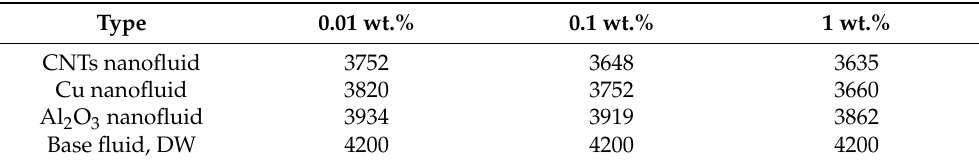
Table 3. Effect of varying nanoparticle concentration on the specific heat (J/kg · ◦ C) of nanofluids obtained from the